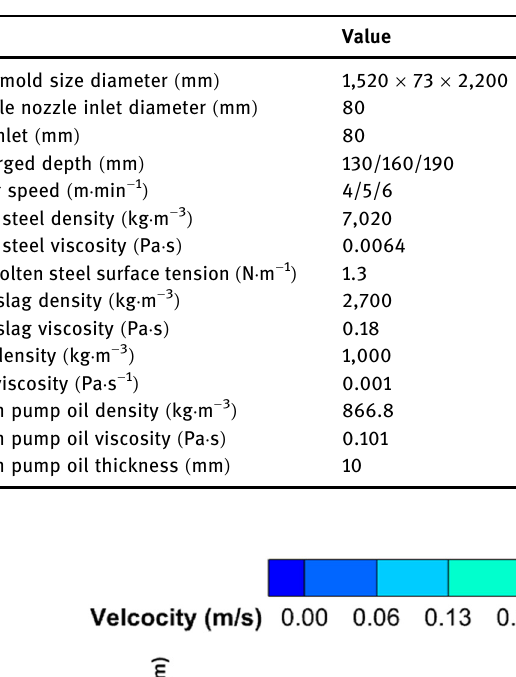
Table 1: Parameters used in physical and numerical simulations